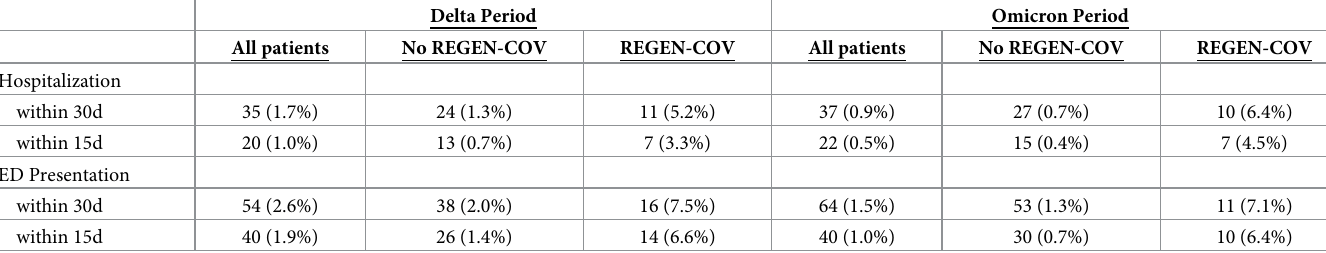
Table 2. Outcomes by time period and REGEN-COV receipt.